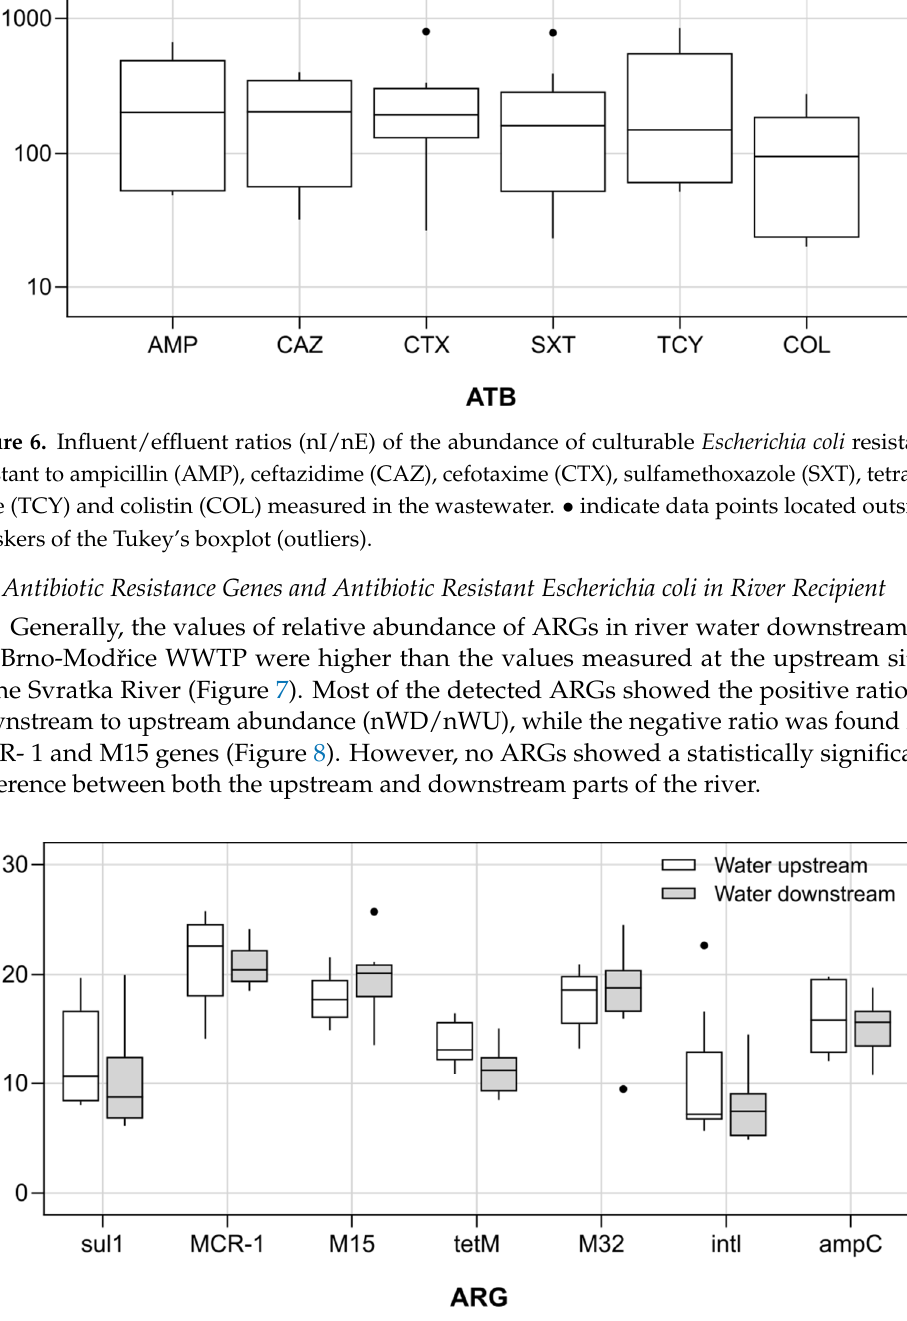
Figure 5. Box plots of the abundance of culturable Escherichia coli resistant to ampicillin (AMP), ceftazidime (CAZ), cefotaxime (CTX), sulfamethoxazole (SXT), tetracycline (TCY) and colistin (COL) measured in the wastewater entering WWTP and treated effluents from WWTP.